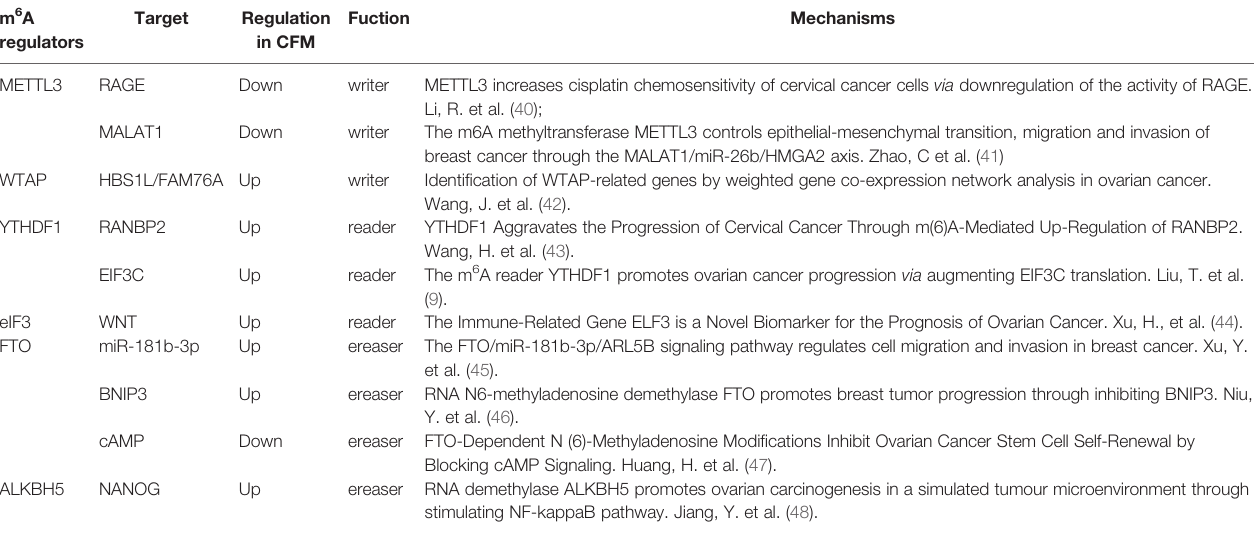
TABLE 1 | Dysregulation of m6A modi fi cation in common female malignant